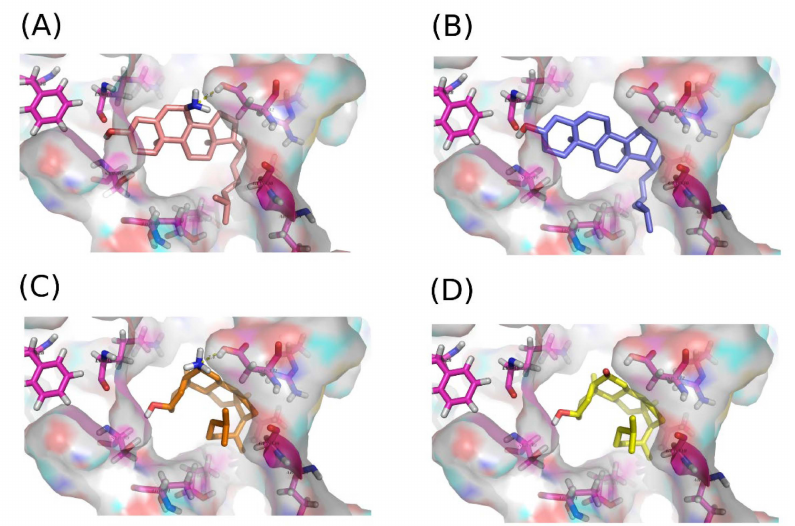
Figure 5. Docking poses of 7- α -aminocholesterol and its analogs on LieIF4A protein. Best scored docking pose of ( A ) 7- α -aminocholesterol, ( B ) cholesterol, ( C ) 6- α -aminocholestanol and ( D ) 6- ketocholestanol. Compounds 7-aminocholesterol and 6- α -aminocholestanol established a stable H-bond with Asp332 from motif V, shown in dashed lines with their estimated length in Å.